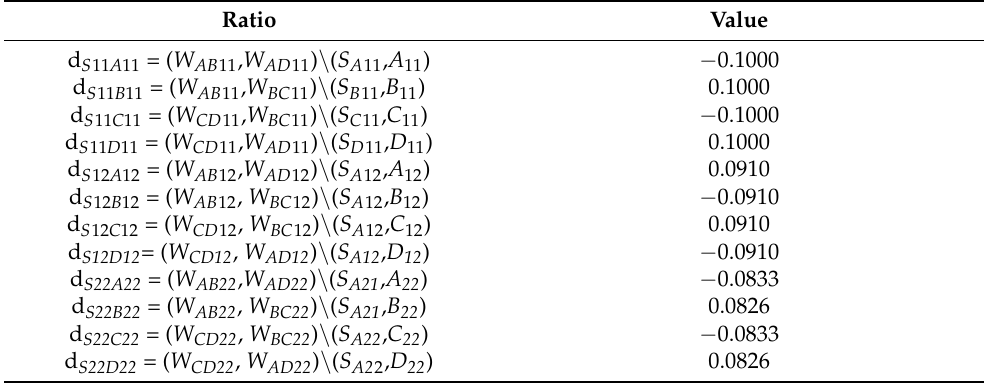
Table A5. The values of the division coefficients (for i, j = 1, 2) used to estimate the folding of Ω ( B v ).